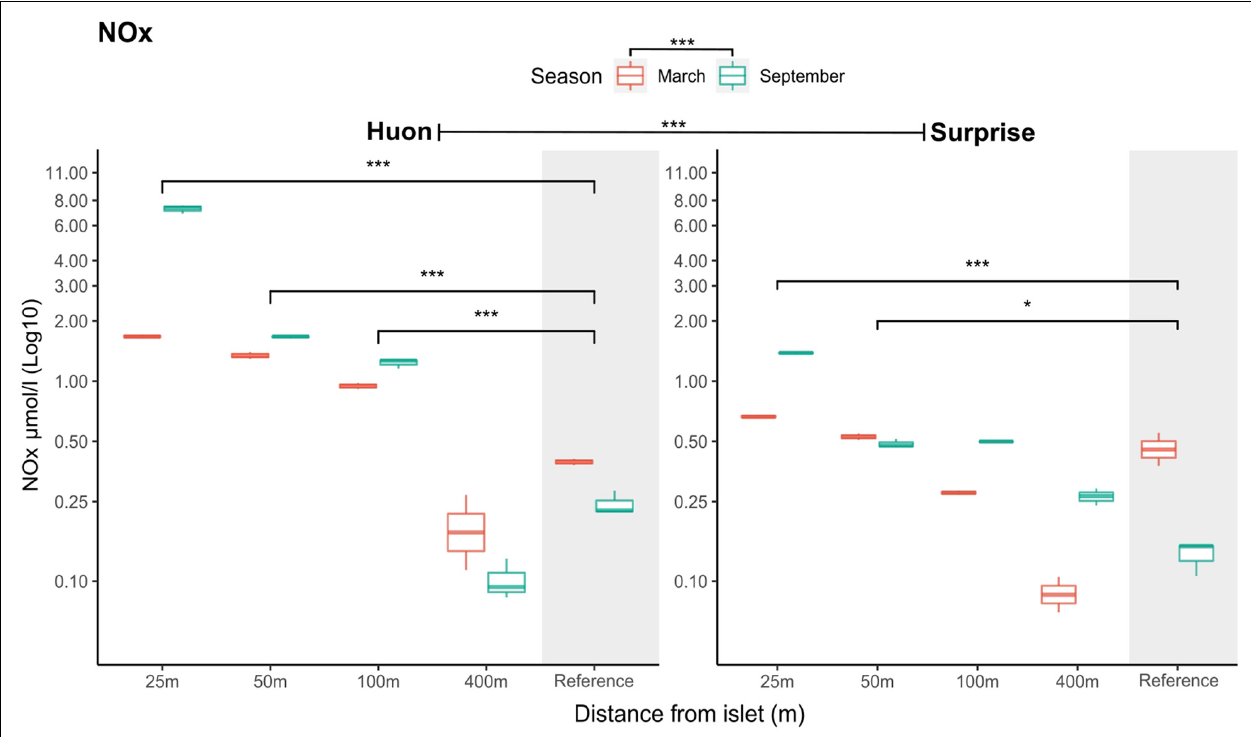
FIGURE 2 | Spatial and temporal variations in the concentration of NOx in seawater. Asterisks show: (i) On top of the figure: a significant positive fixed effect of one season compared to the other (higher in Sept.), (ii) between site names: a significant fixed effect compared to the other site (higher at Huon), and (iii) between the reference site and the transect stations: significant differences in the transect per site effect (higher closer to shore). * Stands for p < 0.05, ** for p < 0.01, and *** for p < 0.001.